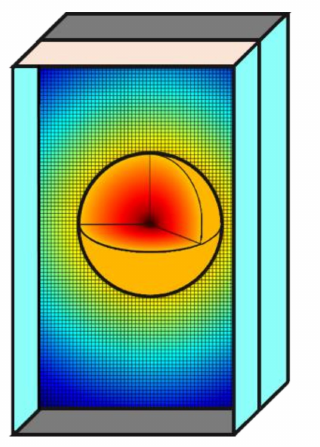
Figure 2. 4D level set